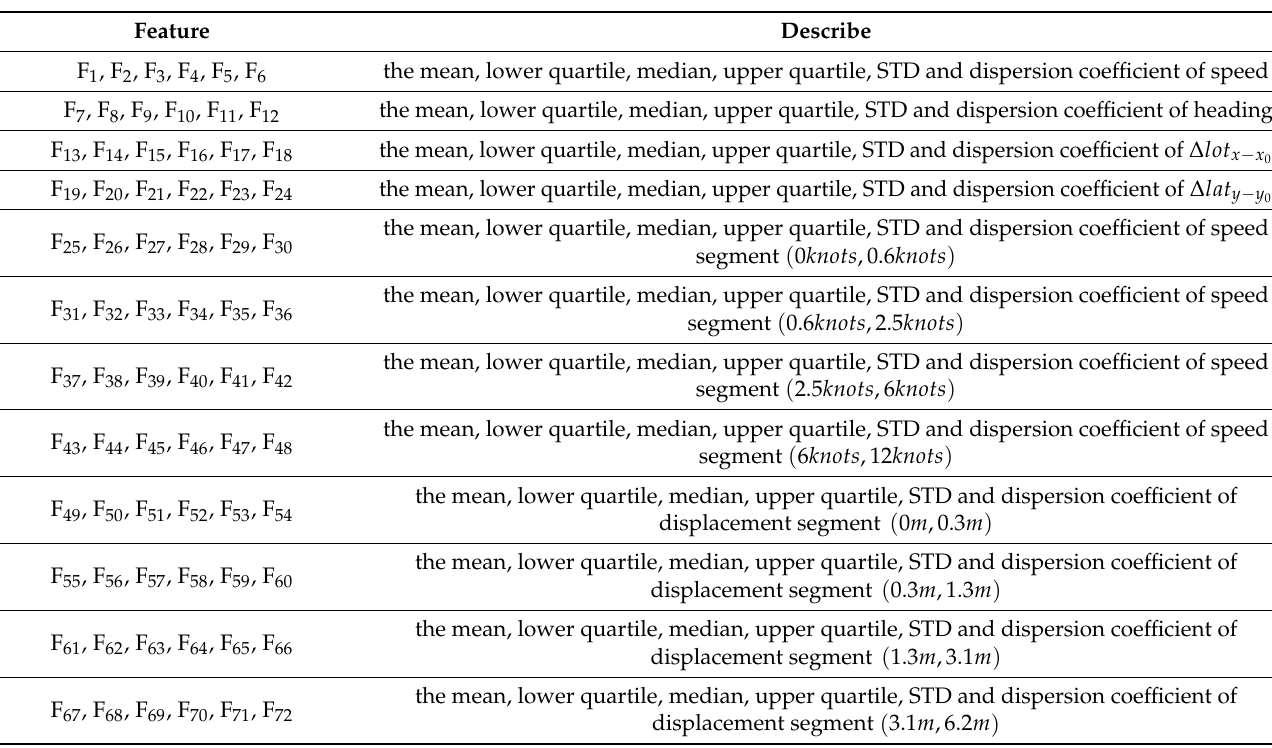
Table 3. Description of each